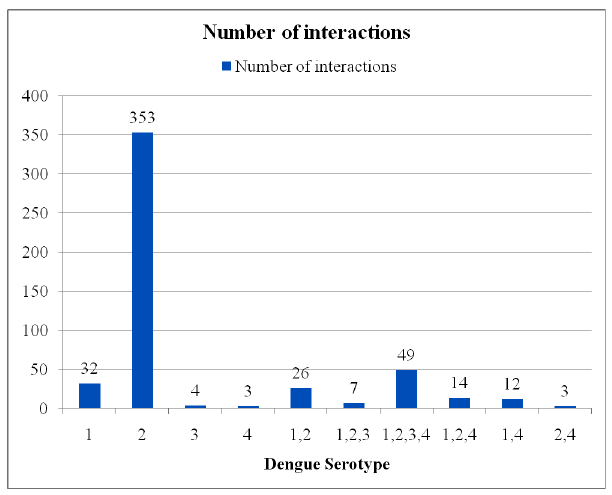
Fig 7. Number of dengue–human interactions with the corresponding proteins, with 1, 2, 3, 4, or a subset of serotypes. Dengueserotype 2 interacts with maximum number of humanproteins